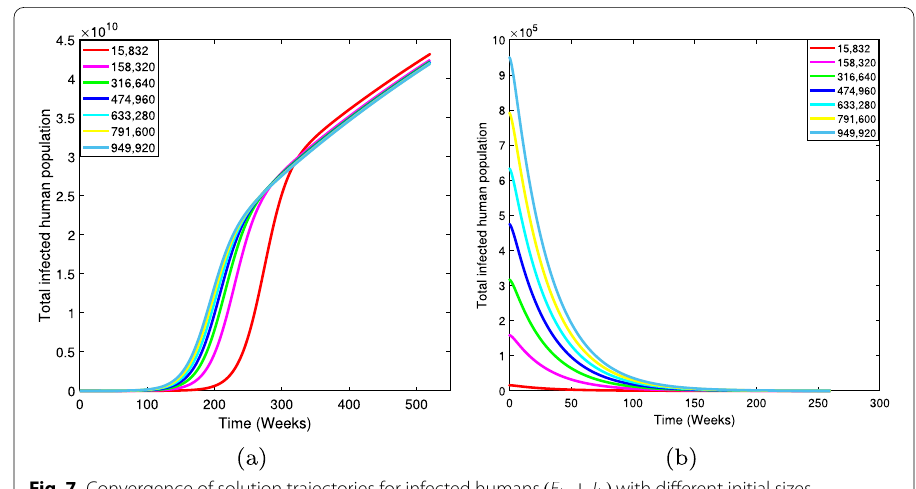
Fig. 7 Convergence of solution trajectories for infected humans ( E h + I h ) with different initial sizes. Parameter values used are as given in Table 2 except for a β h = 1.6889 so that R 0 = 3.22 > 1. ; b β h = 0.2815, σ h = 0.3701, µ r = 0.1882, β r = 0.0124 so that R 0 = 0.50 <